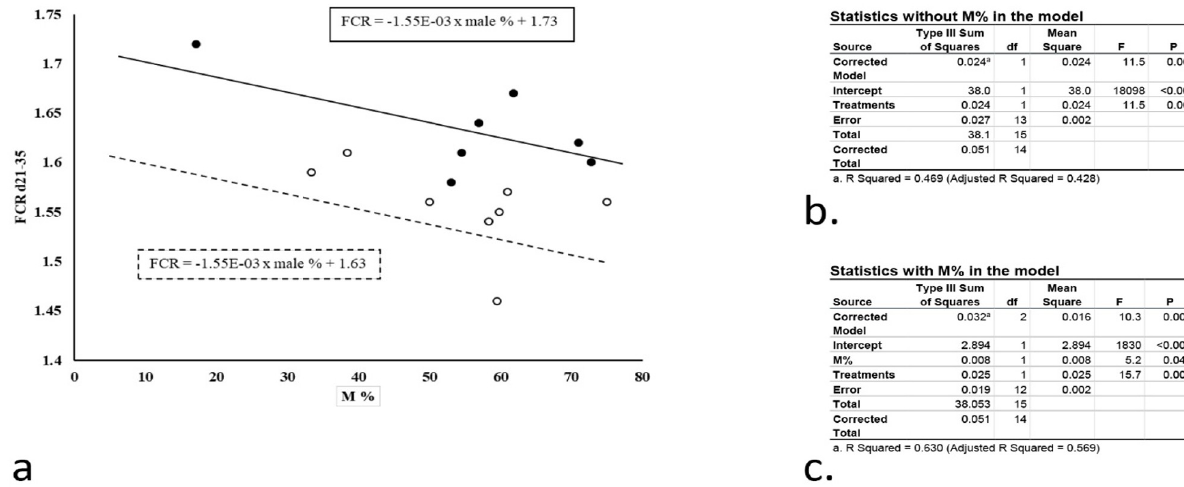
Fig 1. The benefit of the inclusion of male % as a covariate in the statistical analysis model. a. FCR during d 21–35 was plotted against the male %; b. the statistical analysis outcome without the inclusion of male % as a covariate; c. the statistical analysis outcome with the inclusion of male % as a covariate. "solid line" Treatment with antibiotic; "dashed line" Treatment with a mixture of additives; "filled circle" FCR of pens fed diet with antibiotic supplementation; "unfilled circle" FCR of pens fed diet with a mixture of additives supplementation.